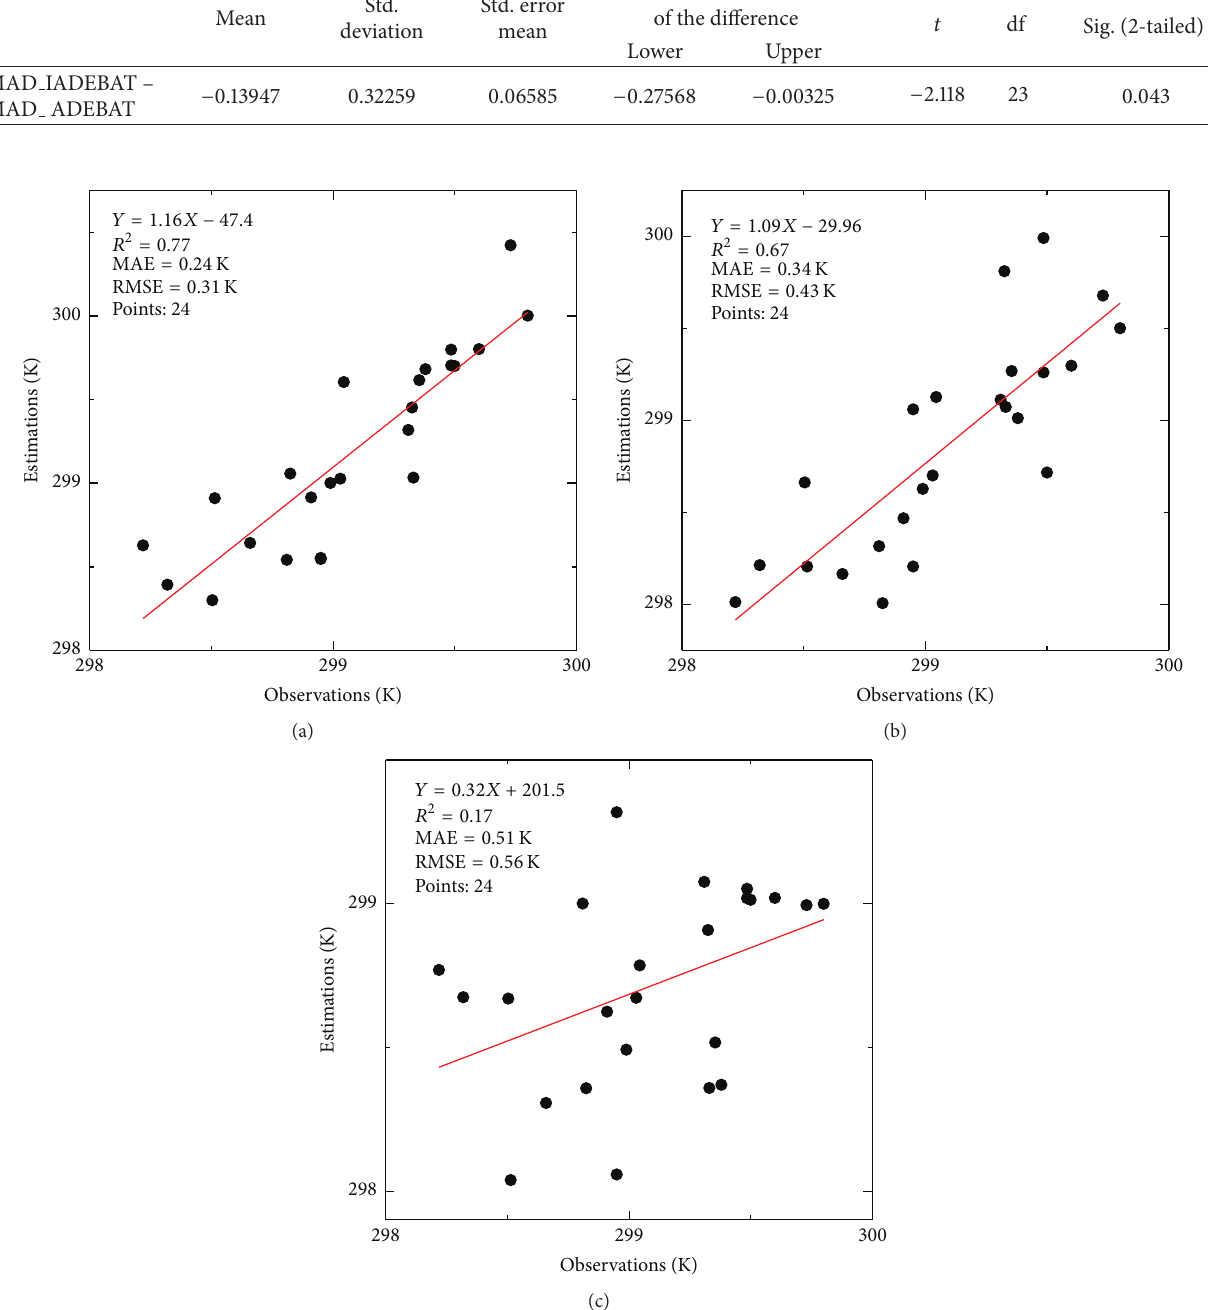
𝑡 df Sig. (2-tailed)Mean